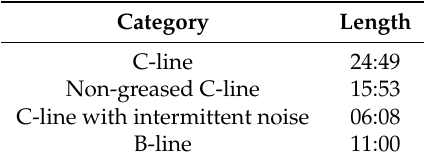
Figure 10. Receiver Operation Characteristic (ROC) curve of the proposed method for each category corresponding to Table 1. The accuracy is measured by the Area Under the ROC Curve (AUC). Note that this is not a multi-classification result, but an individual ROC curve with a normal C-line. Table 1. Dataset of audio records in the